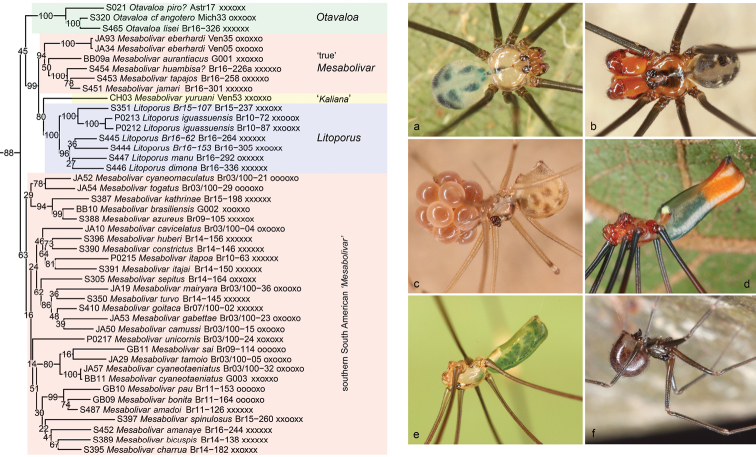
Mesabolivar clade aOtavaloalisei (Brazil) bMesabolivarmaraba (Brazil) cLitoporus sp. n. “Br16-153” (Brazil) dMesabolivarcyaneotaeniatus (Brazil) eMesabolivarkathrinae (Brazil) fMesabolivarsaci (Brazil).